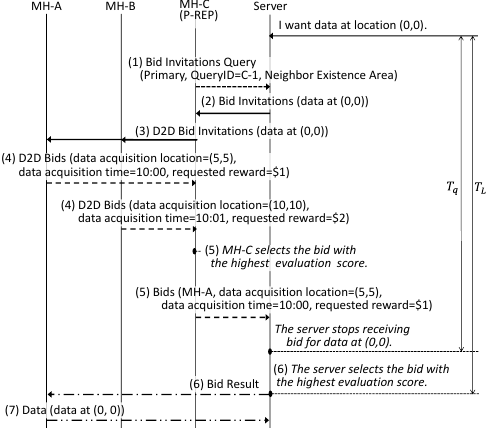
Figure 13. Example of the RevAuc procedure carried out by a P-REP.